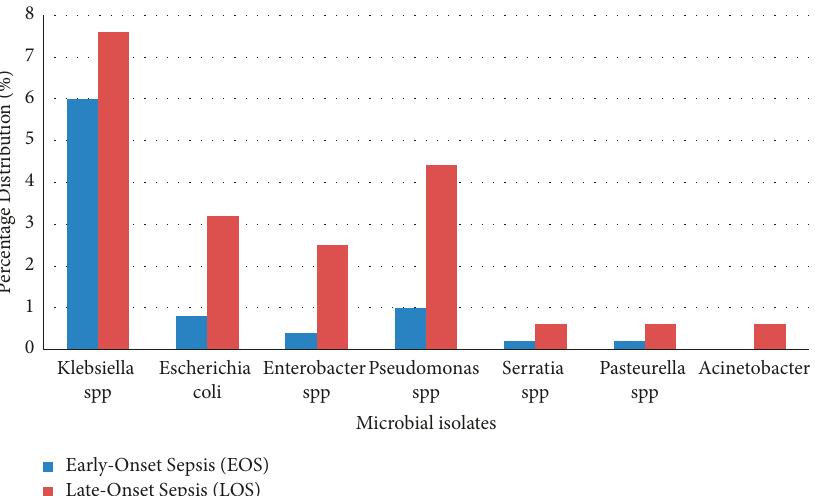
Figure 2: Distribution of Gram-negative bacteria in EOS and LOS.